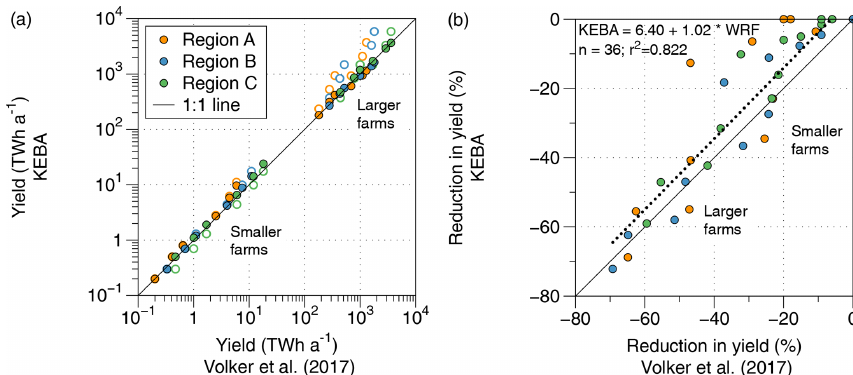
Figure 3. (a) Comparison of yields for the scenarios of Table 2 estimated by KEBA and as reported by Volker et al. (2017). The open circles represent wind energy estimates that do not take wind speed reductions into account (“isolated”, with f red = 1). (b) Relative yield reductions compared to the case of isolated turbines without the wind speed reduction effect. The dotted line reflects a linear regression between the two estimates, with the regression equation provided in the figure. Table 4. Mean yields estimated for the case of isolated wind turbines (without wind speed reductions) and yield estimates with wind speed reductions by KEBA and by Volker et al. (2017) for three regions (A, B, and C). “CF” stands for capacity factor ( P el , tot /NP el , max ). The ranges for the “KEBA” and “Volker et al. (2017)” cases refer to the different sizes of the wind farms (small, medium, large, X-large), with lowest CFs and yields representing the estimates of the largest wind farms. Scenario Isolated